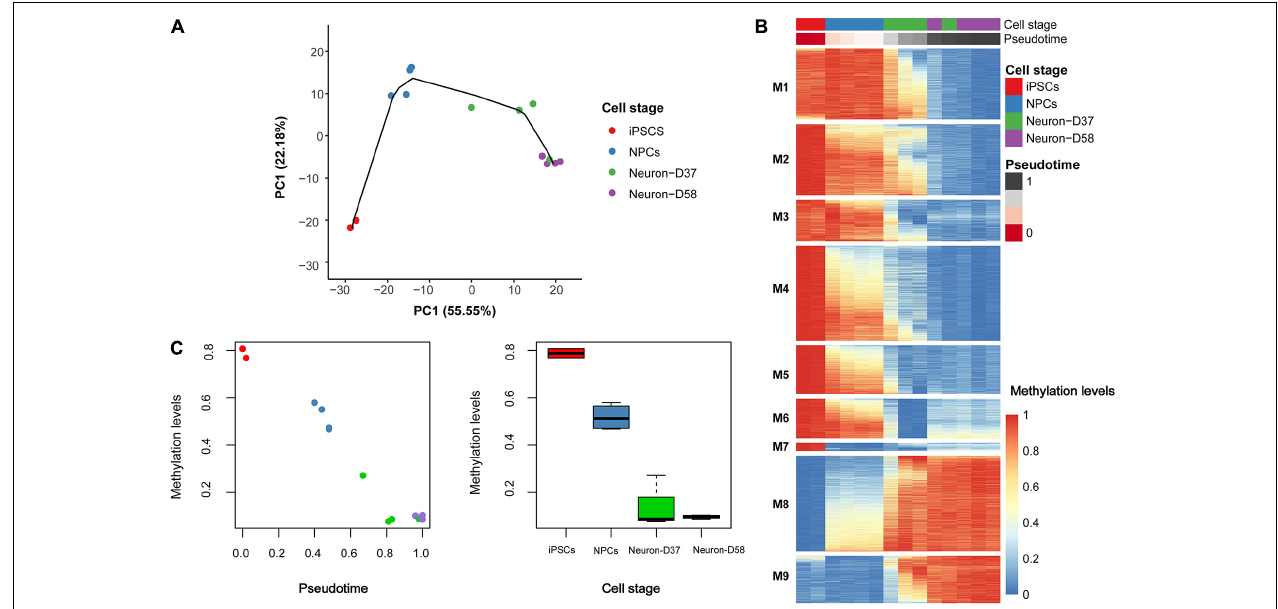
FIGURE 2 | Trajectory inference modeling identifies a signature of 6,843 probes that distinguish cell stage. (A) To create the trajectory model dimensionality reduction was first performed, using principal component analysis (PCA), followed by estimating pseudo-time to model the lineage trajectory. The different samples grouped together based on the first two principal components (PCs). (B) Using the pseudo-time estimation, a generalized additive model (GAM) was used to determine which of the 6,843 probes were becoming hypomethylated (blue) or hypermethylated (red) over time. The patterns of hypomethylation and hypermethylation were grouped into nine modules (M1-9) that could distinguish the different cell stages. (C) The DNA methylation patterns occurring at the most significant probe (cg00908292) throughout differentiation. Left: plot of methylation beta-value (Y-axis) against pseudo-time (X-axis) and right: plot of methylation beta-value (Y-axis) against cellular stage